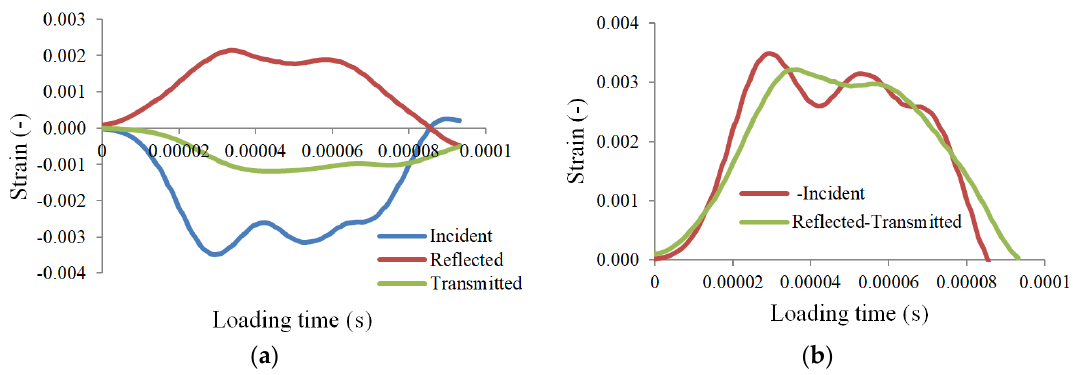
Figure 8. ( a ) Elastic waves measured during the dynamic compression of concrete with an impact velocity 30 m/s (length of the specimen 0.05 m); ( b ) force equilibrium, input and output forces.